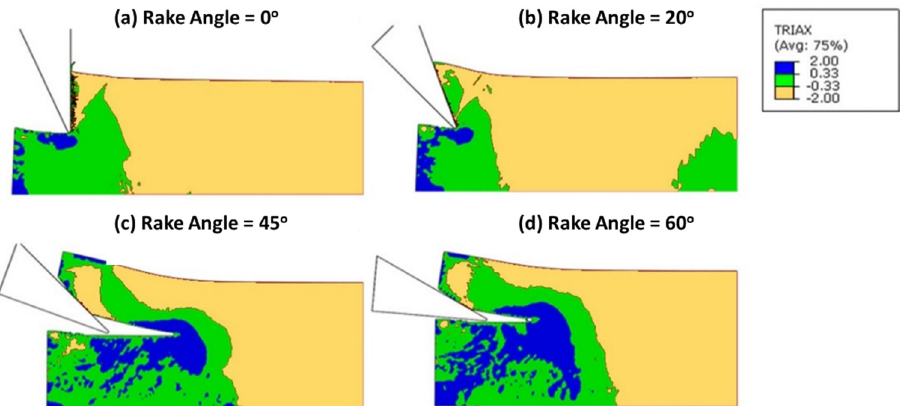
Figure 8. Contour plot illustrating the stress triaxiality involved in the high-speed orthogonal cutting of PU foams at a cutting depth of h = 2 mm and rake angles of ( a ) α = 0 ◦ ; ( b ) α = 20 ◦ ; ( c ) α = 45 ◦ ; ( d ) α = 60 ◦ . Green regions are stress triaxiality values within the limits of − 0.33 < η < 0.33, and regions of blue and red are values of stress triaxiality above and below the limits, respectively.